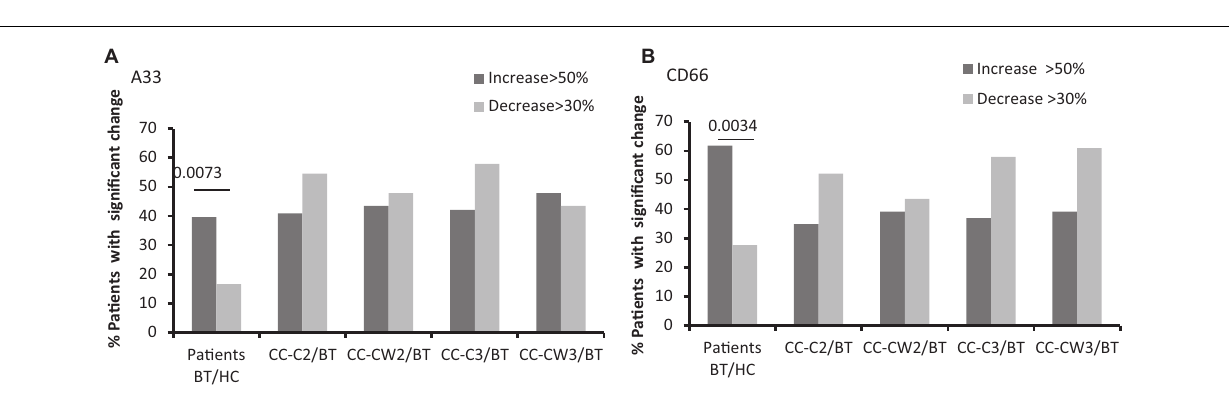
FIGURE 3 | EVs tumor cell markers. Antigen levels of tumorigenic markers were measured on EVs obtained from healthy controls and on EVs obtained from patients (CC-C and CC-W) before chemotherapy (BT, time point 1), during treatment (time point 2), and at the end of chemotherapy treatment (time point 3). The percentage of labeled EVs was calculated from the total number of EVs using FACS analysis. The graph presents significant changes ( > 50% increase or > 30% decrease) in patient EVs levels BT compared to HC and the change during treatment and at the end of chemotherapy treatment compared to the levels BT of EVSA33 antigen (A) ; EVs CD66 (B)